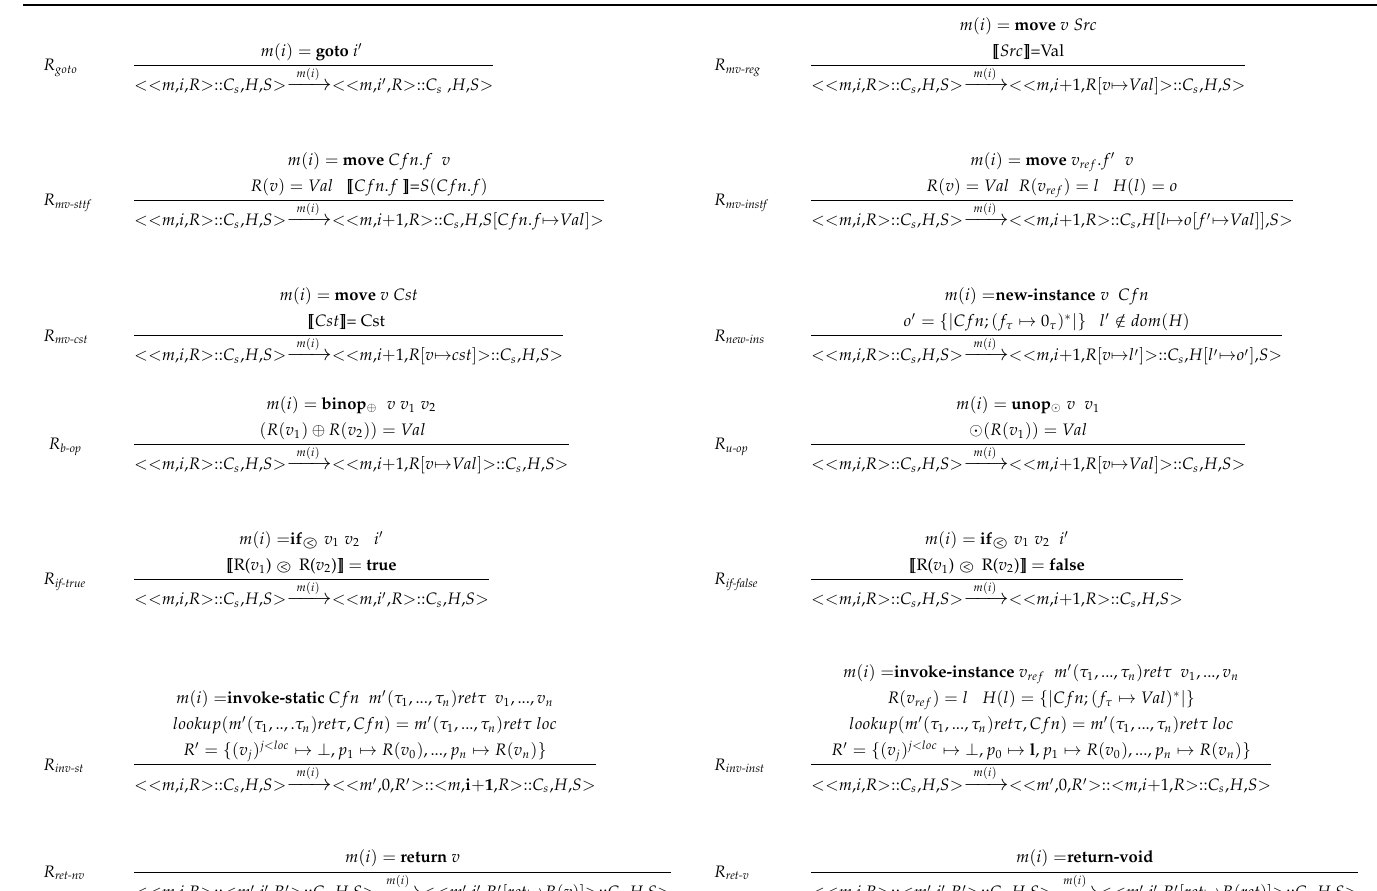
Table 5. Single-threaded